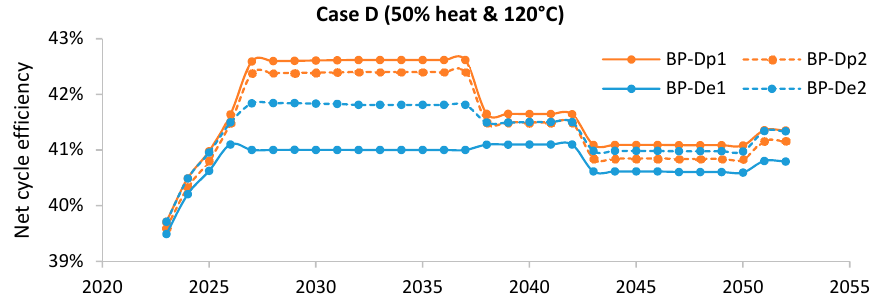
Figure 7. Performances of backpressure steam turbine cycles defined for case D.